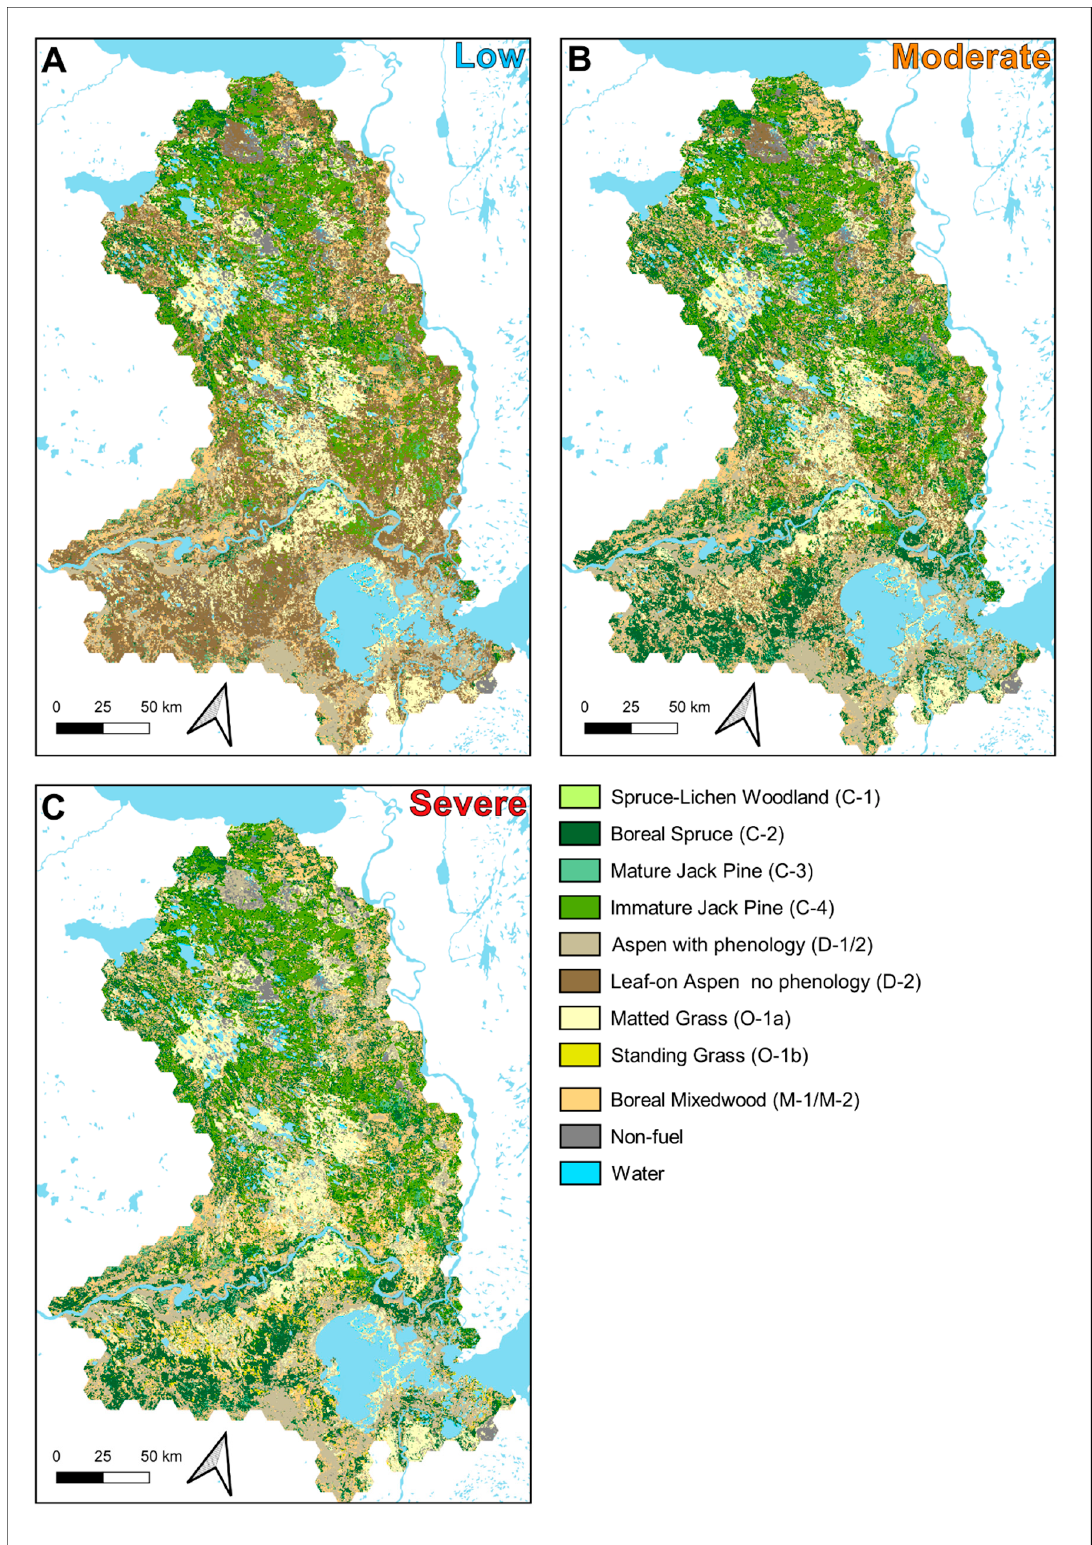
Figure 2. Canadian Fire Behavior Prediction System fuels maps corresponding to the differing drought scenarios ( A ) low; ( B ) moderate; ( C ) severe.